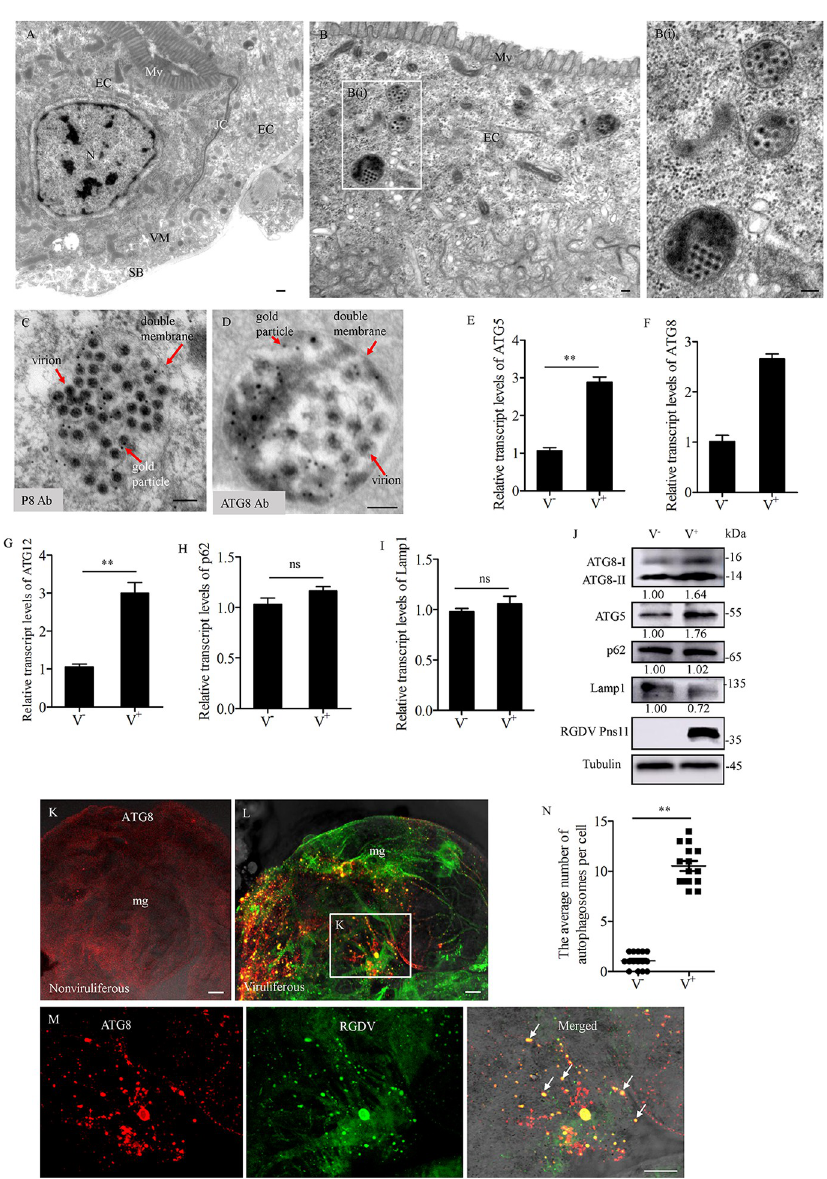
Fig 1. RGDV infection induces autophagosome formation in the intestines of R . dorsalis . ( A-D ) Transmission electron micrographs showing virus-induced autophagosomes in the midgut epithelial cells. ( A ) The midgut epithelium, showing microvilli, intercellular tight junctions, visceral muscles, and serosal barrier. ( B ) Virus-containing autophagosomes within virus-infected midgut epithelium. Panel B (I) is an enlargement of the boxed area in panel B . EC, epithelial cell; JC, junctional complexes; N, nucleus; Mv, microvilli; VM, visceral muscles; SB, serosal barrier. ( C, D ) Immunogold labeling of RGDV P8 ( C ) or ATG8 ( D ) in virus-containing autophagosomes. Virus-infected intestines of R . dorsalis were immunolabeled with P8- ( C ) or ATG8- ( D ) specific IgG as the primary antibody, followed by treatment with 10-nm gold particle-conjugated IgG as the secondary antibody. ( E-I ) Relative transcript levels for ATG5 ( E ), ATG8 ( F ), ATG12 ( G ), p62 ( H ) and Lamp1 ( I ) genes in nonvirulifeorus or viruliferous insects, as detected by RT-qPCR assay. Bars represent means ± SD from three independent experiments. Significance ( �� ) was determined at P < 0.01. ns, not significant. ( J ) Relative protein expression levels of ATG8, ATG5, p62, Lamp1 and Pns11 in nonviruliferous or viruliferous insects as detected by western blot assay. Insect Tubulin was detected as a control. Relative protein levels were determined using ImageJ and the accumulation levels of ATG8-II, ATG5, p62, and Lamp1 in nonviruliferous insects were normalized to 1. ( K-M ) Immunofluorescence assay showing the distribution of ATG8-puncta in the midgut epithelial cells from nonviruliferous ( K ) or viruliferous ( L ) insects. The intestines were immunostained with P8-FITC (green) and ATG8-rhodamine (red). Panel M was an enlargement of the boxed area in panel L to show the colocalization of P8 and ATG8 (arrows). ( N ) The average number of ATG8-puncta per cell